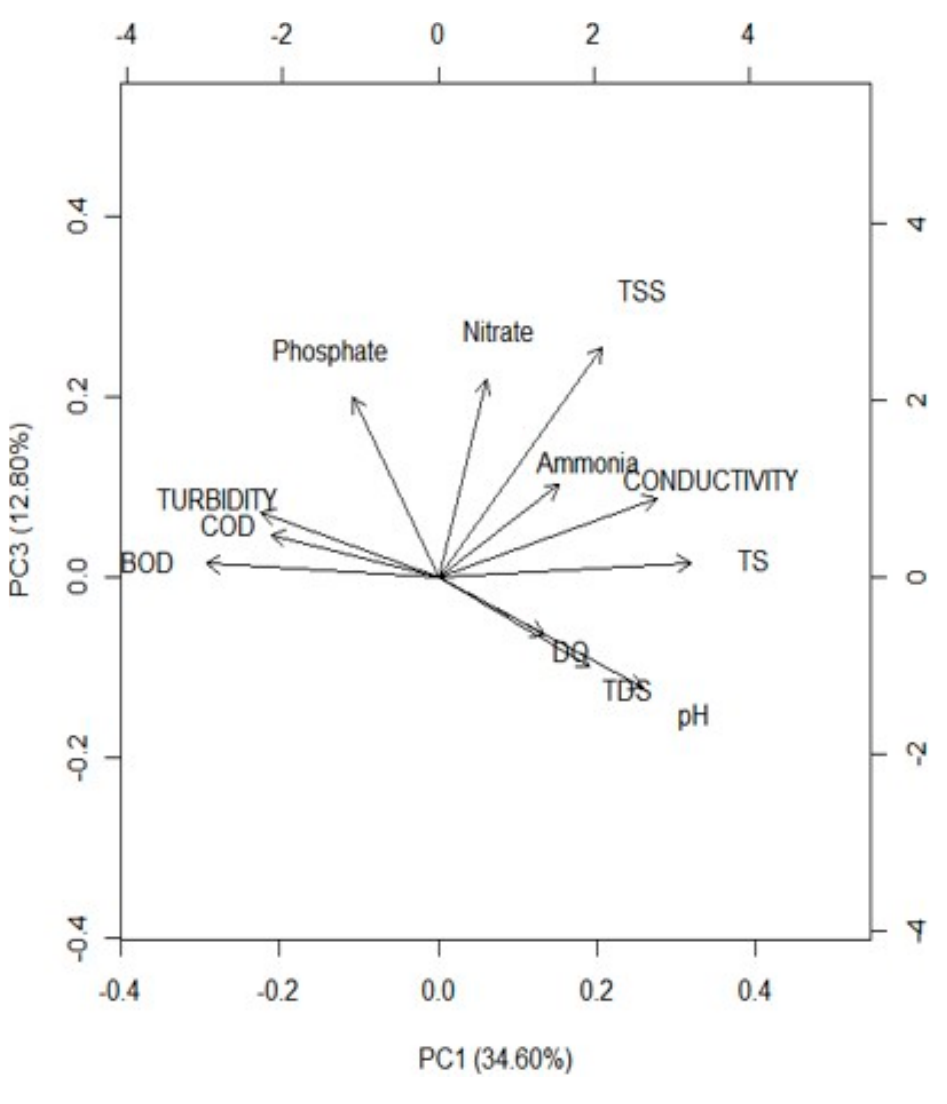
Figure 8. Biplots PC1 vs. PC2.